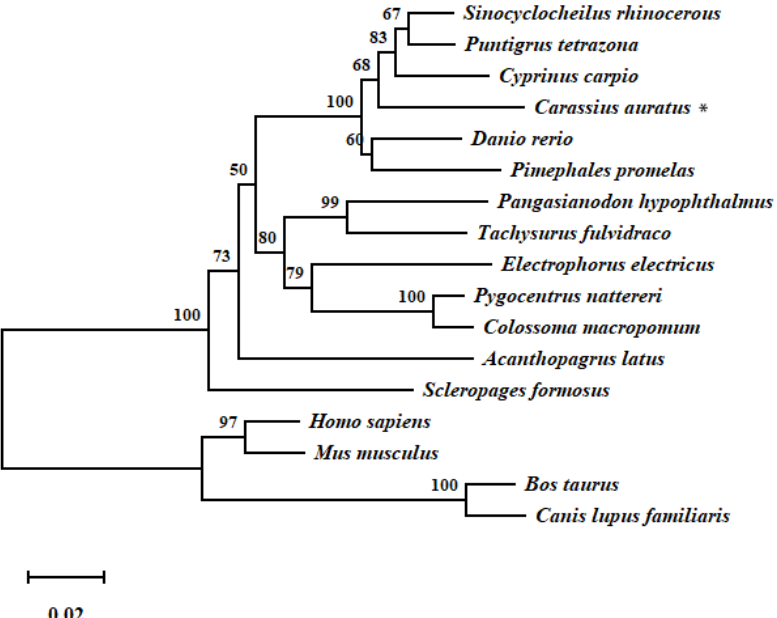
Figure 2. Neighbor ‐ joining phylogenetic tree of TCC gls1 . The GenBank accessions numbers are: Figure 2. Neighbor-joining phylogenetic tree of TCC gls1 . The GenBank accessions numbers are: Sinocy- Sinocyclocheilus